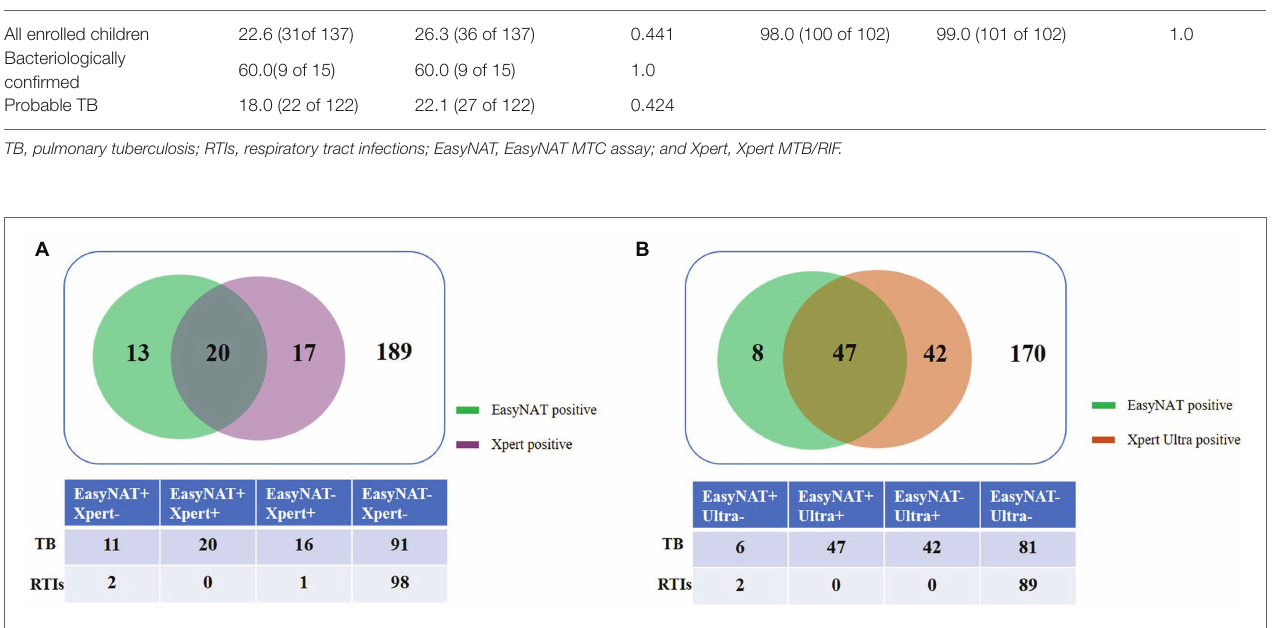
FIGURE 2 | Venn diagram of the different diagnostic test results for childhood tuberculosis using gastric aspirate samples. (A) EasyNAT MTC and Xpert MTB/RIF. (B) EasyNAT MTC and Xpert MTB/RIF